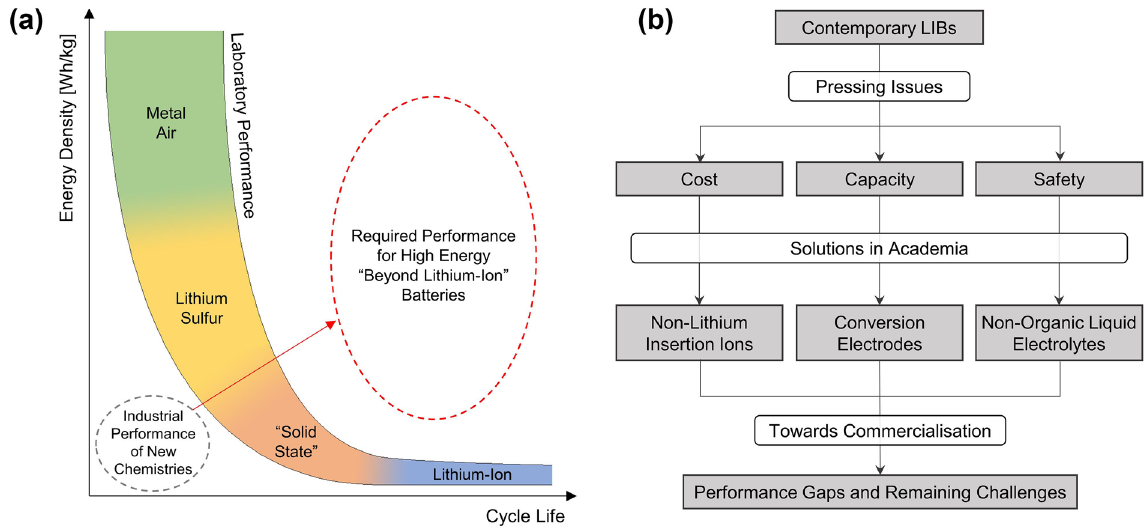
Fig. 1 a General performance for LIBs and popular new chemistries along with emerging commercial examples of the latter, compared with the region of performance required by future applications. b Flowchart describing the sequence of content for this